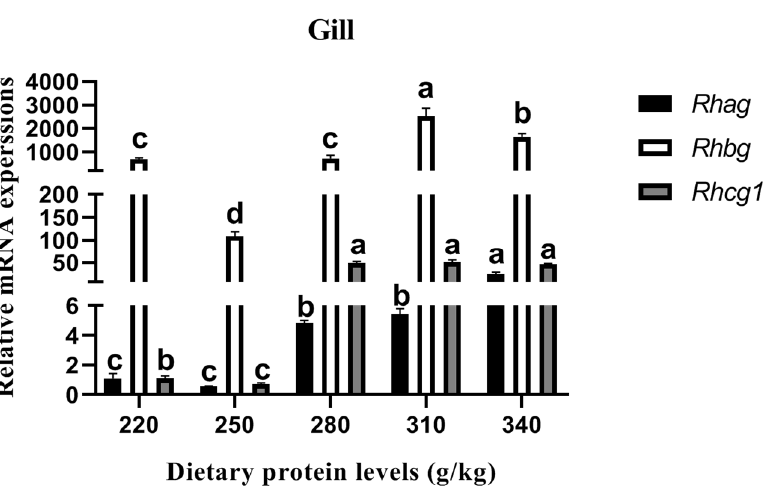
Figure 3. Effects of different dietary protein levels on the RH gene expression of Cyprinus carpio haematopterus . Note: Data are presented as means ± standard error (SE). Values with different super- scripts (a, b and c) are significantly different ( p < 0.05). Abbreviations: Rhag , Rhesus a glycoprotein; Rhbg , Rhesus b glycoprotein; Rhcg1 , Rhesus c glycoprotein 1.